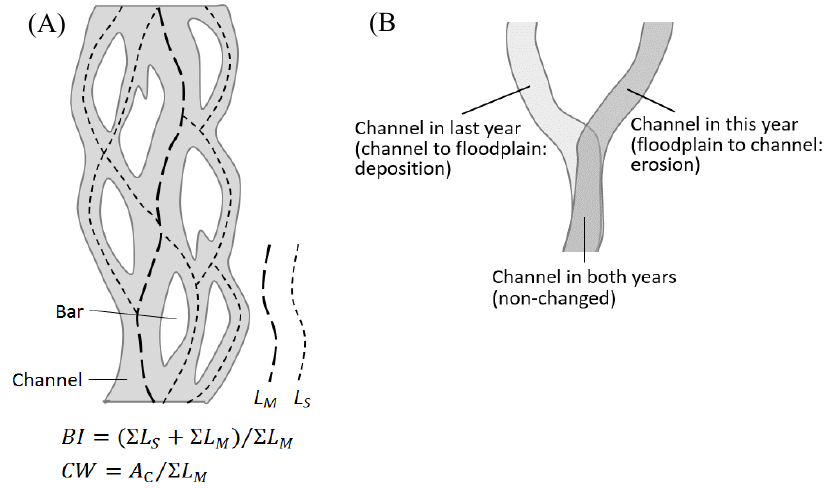
Figure 3. ( A ) Illustration for calculating braid index ( BI ) and active channel width ( CW ); ( B )